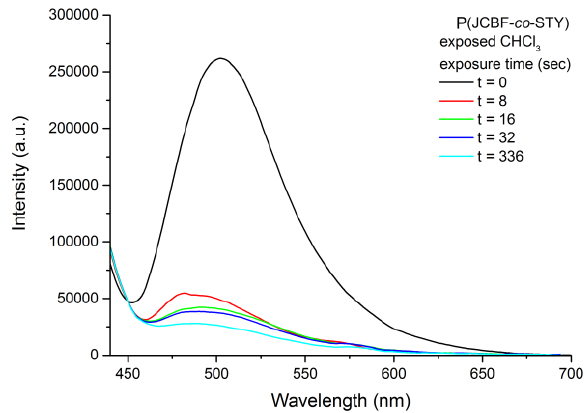
Figure 3. Progressive changes in the fluorescence emission ( λ exc. = 410 nm) of P(STY-co-JCBF)(0.34) film as a function of the exposure to chloroform vapours. The spectra were collected for a total time of 5–6 min.